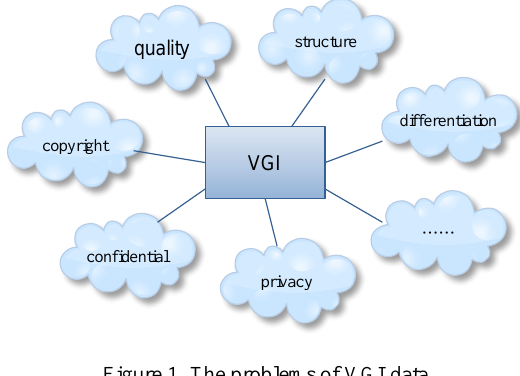
Figure 1. The problems of VGI data